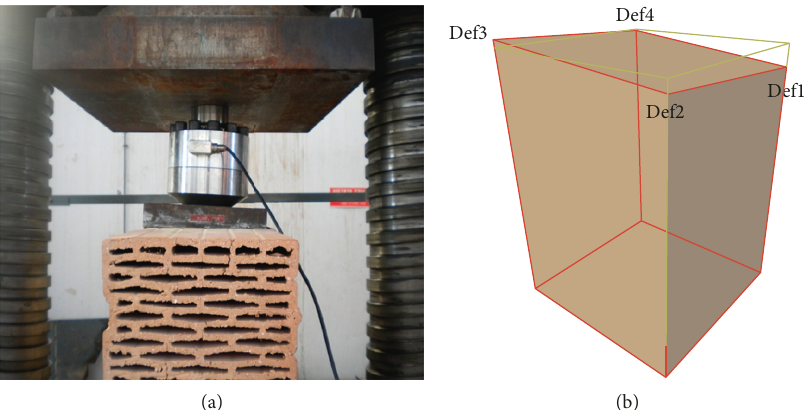
Figure 10: Details of the test on triplets: (a) specimen after the unloading; (b) 3D visual of the displacement at the end of the unloading tests.